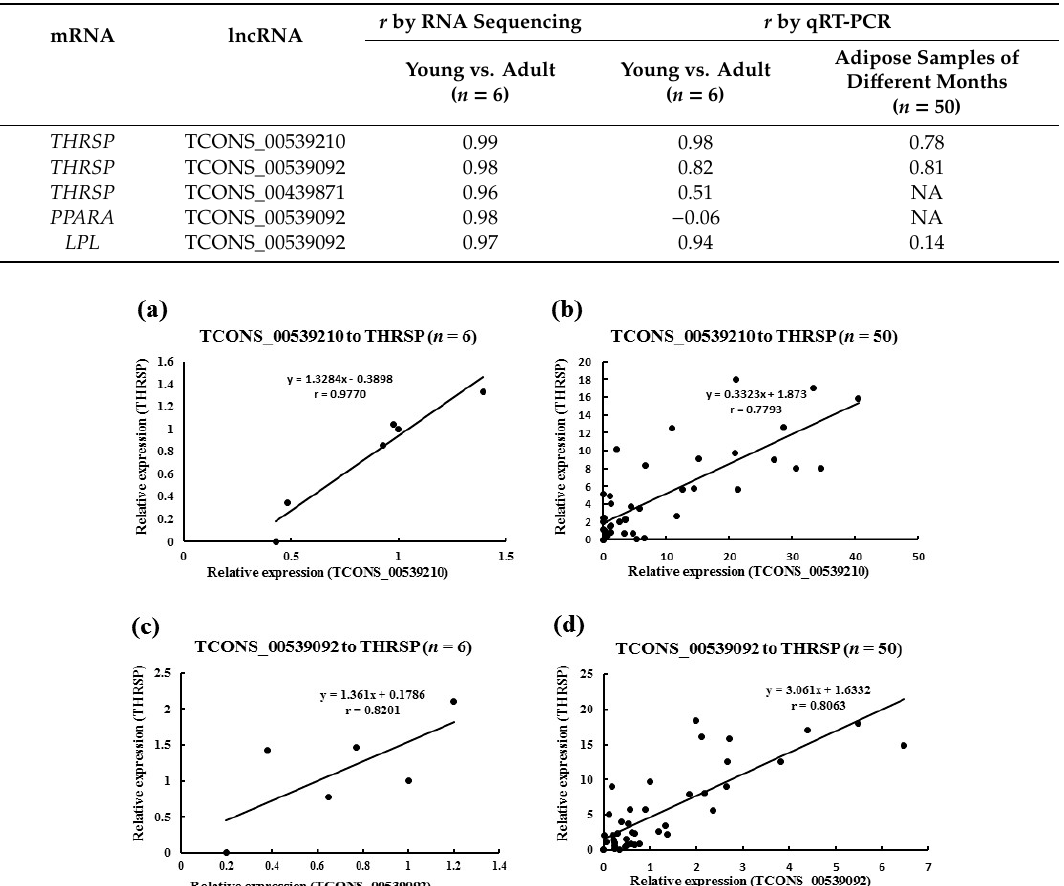
Figure 3. Validation of the two lncRNAs with high correlation to THRSP by qRT-PCR. The axis shows the relative expression of lncRNA and THRSP . Pearson’s correlation coefficients between lncRNA and THRSP based on their relative expressions were calculated to yield an r value. ( a and c ) Validation for TCONS_00539210- THRSP and TCONS_00539092- THRSP in young and adult buffalos, respectively ( n = 6). ( b and d ) Validation for TCONS_00539210- THRSP and TCONS_00539092- THRSP in buffalos with variable months of age, respectively ( n = 50).